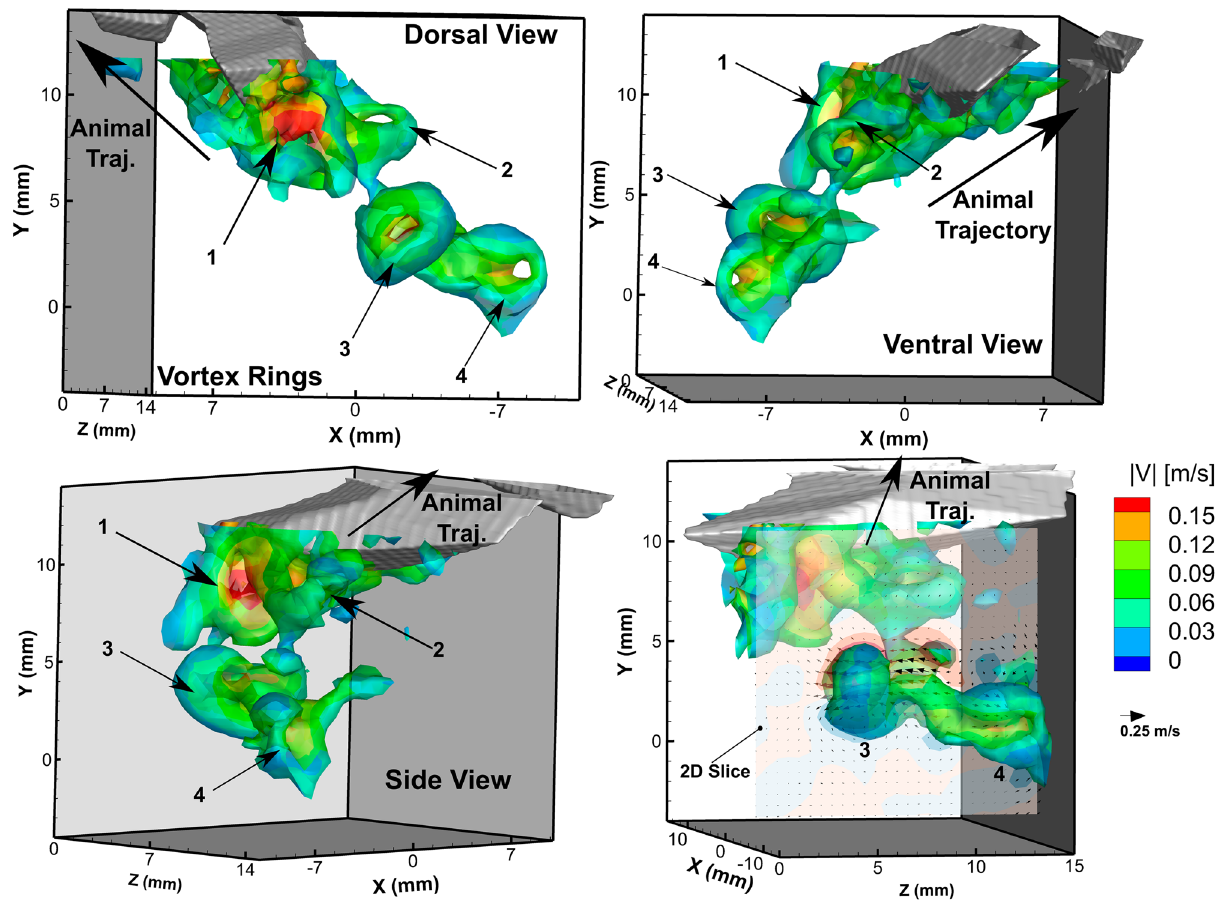
Figure 6. Volumetric isosurface of vorticity magnitude surrounding the antennae and its wake at t* = 0.994 from three perspectives, and a 2D slice of the YZ plane with corresponding velocity vectors bisecting vortex ring 3. The isosurface corresponds to vorticity magnitude of 65 s -1 , and the color contours represent the fluid velocity magnitude along the